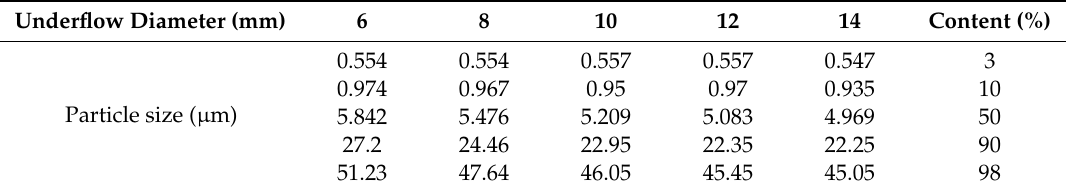
Table 4. Particle size of I outer